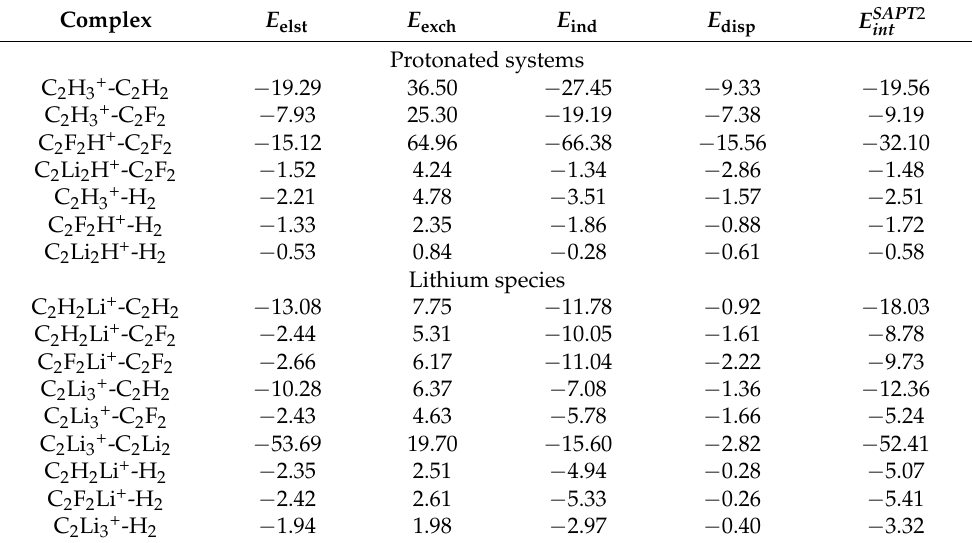
Table 3. The interaction energy contributions (in kcal/mol) that are defined by Equation (5) and the total interaction energy, E SAPT 2 . int Complex E elst E exch E